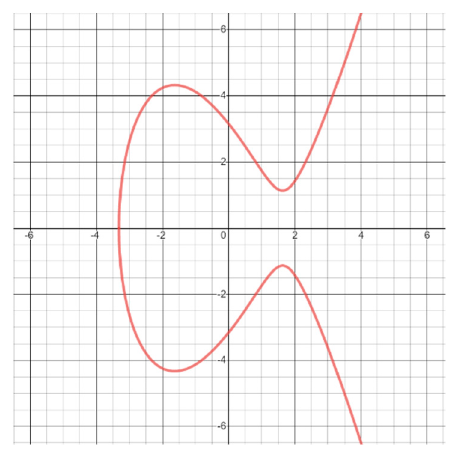
Figure 9. Elliptic curve of y 2 = x 3 + ax + b.